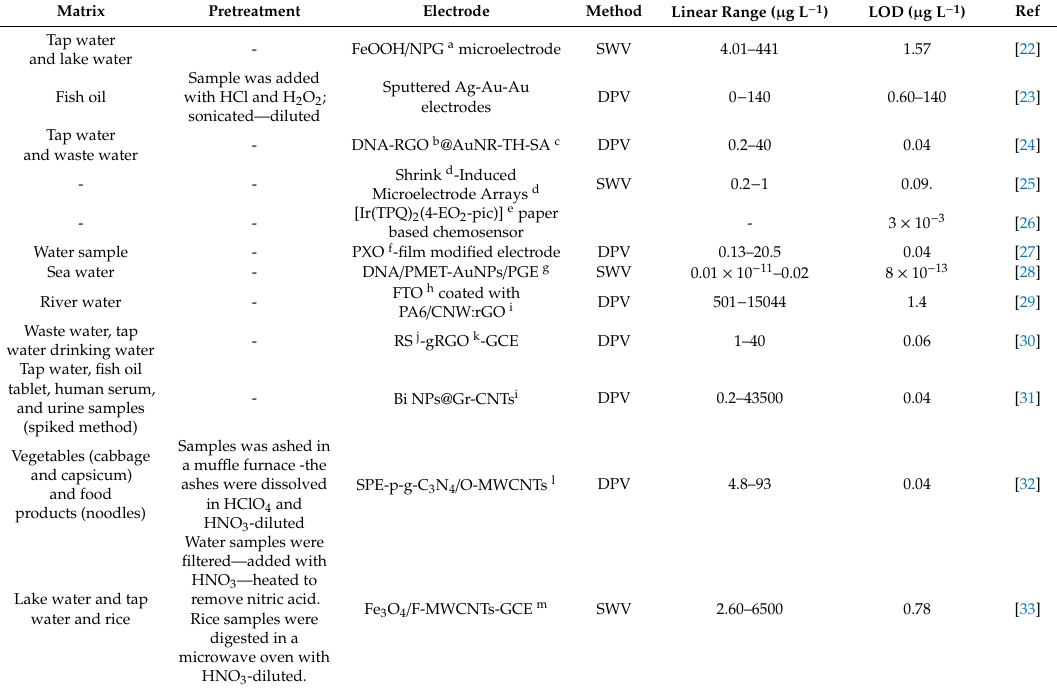
Table 1. Sample matrix, pretreatment, detection limit and linear dynamic range obtained using anodic stripping voltammetry (ASV) with di ff erent electrodes for the determination of mercury, reported in papers published in